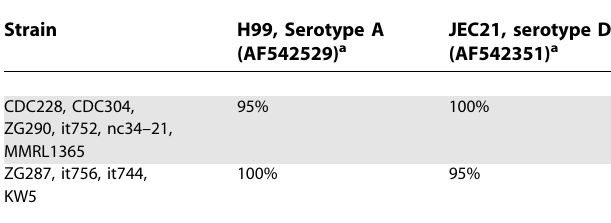
Strains Strain H99, Serotype A JEC21, serotype D (AF542529) a (AF542351)